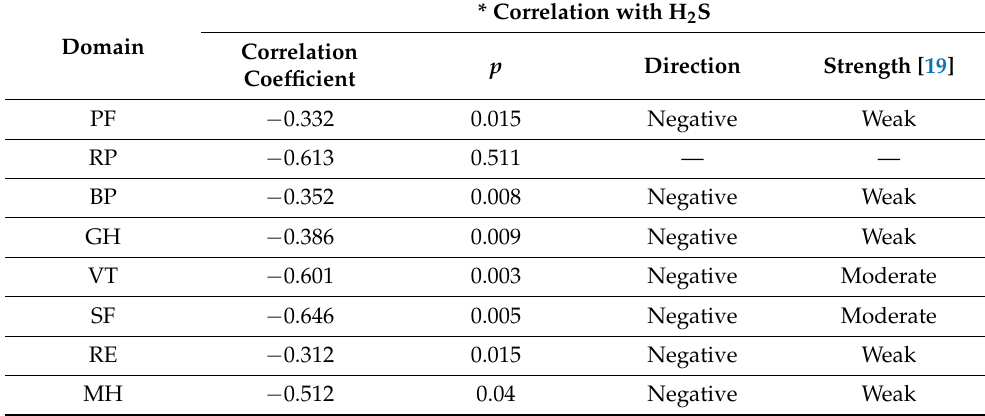
Table 3. SF-36 domains’ and H 2 S correlation.